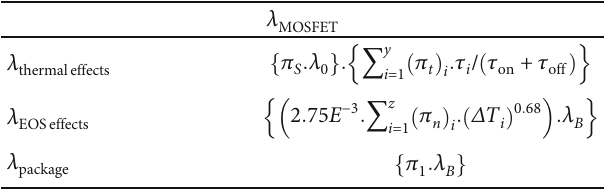
Table 2: Adjustment failure rates for the MOSFET.